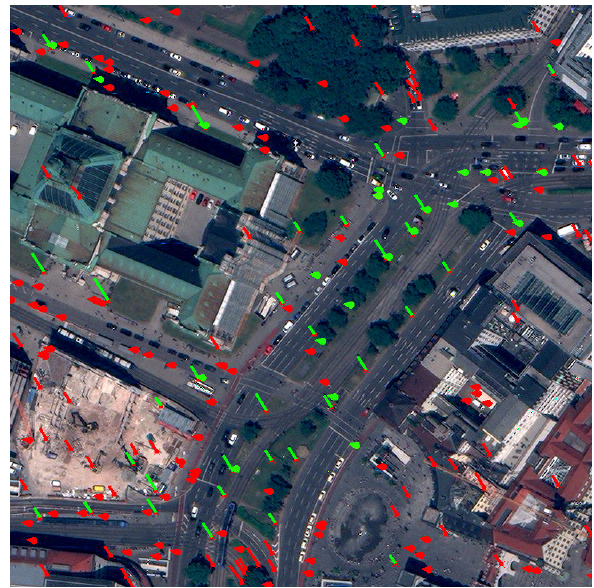
Figure 18. Section 240 × 240 m 2 of fig. 15 showing correct detected poles and GCPs in green and misdetections in red Figure 17. top: section 60 × 36 m 2 of fig. 15 (NE of center, Maximiliansplatz), bottom: details ( 20 × 20 m 2 ) with determined corrections as pink lines from pole footpoint to SAR-GCP